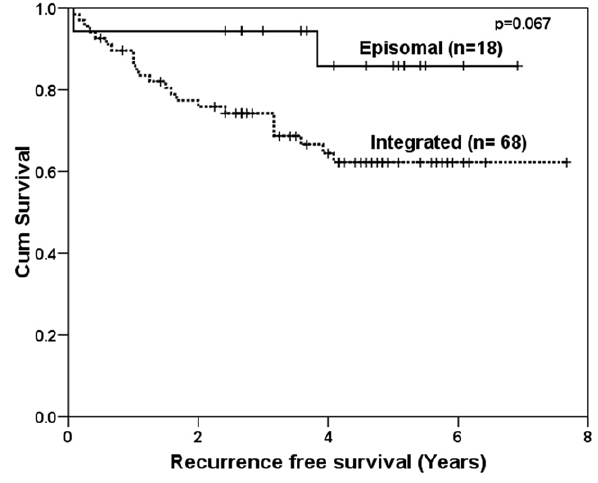
Figure 3. Kaplan-Meier analysis for episomal vs. integrated viral genome. Kaplan-Meier survival curve for patients with episomal form of virus (n=18) vs. integrated form (n=68) is depicted. Most of the patients with episomal form (16 out of 18) had a disease free survival as compared to patients with integrated form, indicating a good clinical outcome, although with a borderline significance